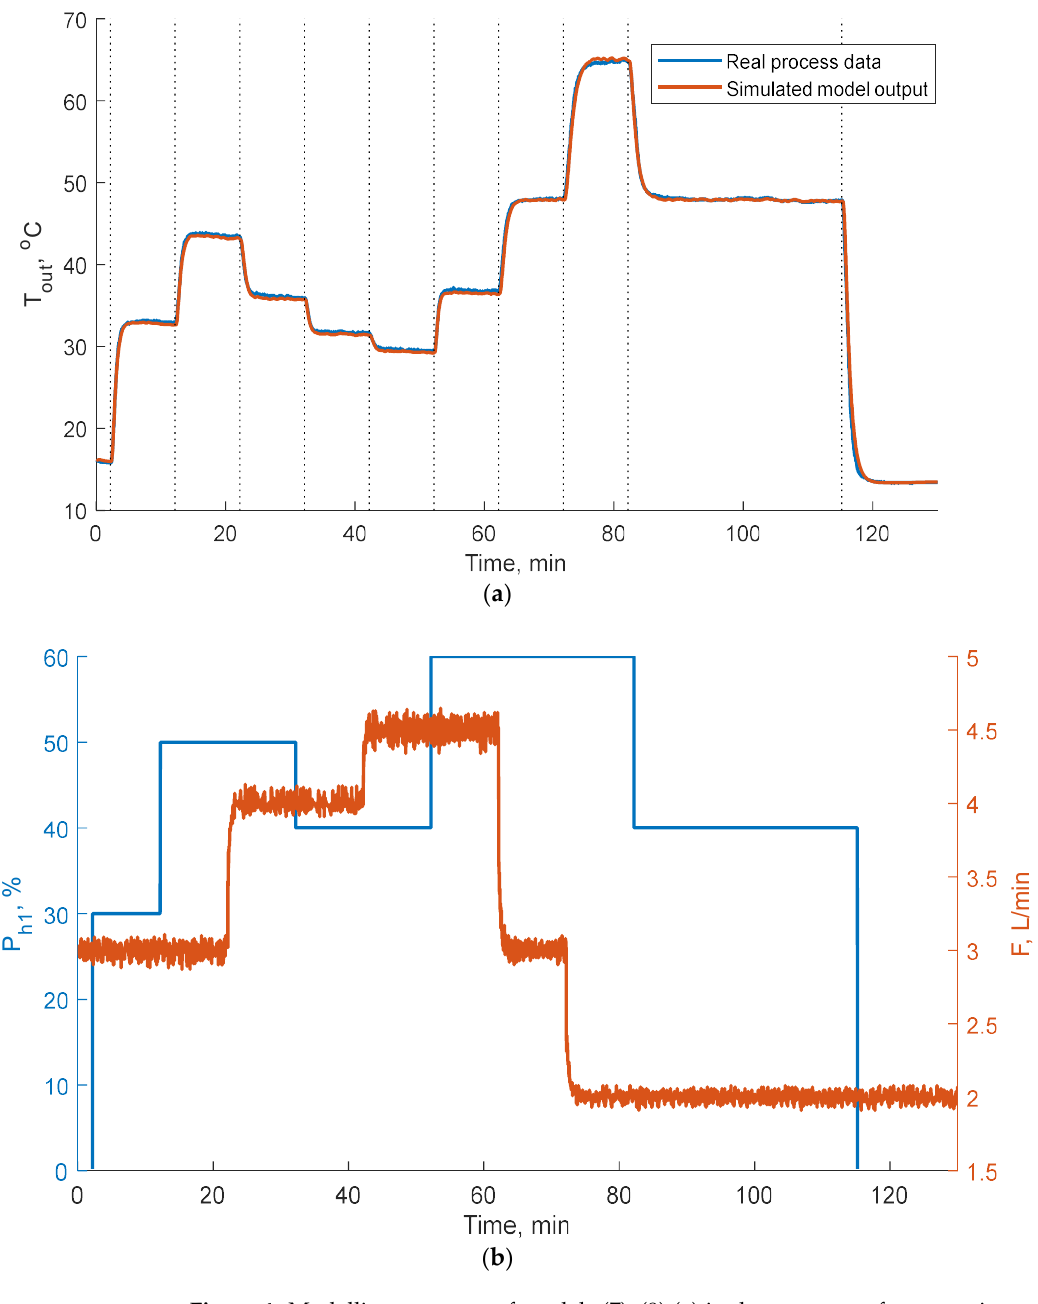
Figure 4. Modelling accuracy of models (7)–(9) ( a ) in the presence of consecutive step changes of power P h1 and flow rate F ( b )